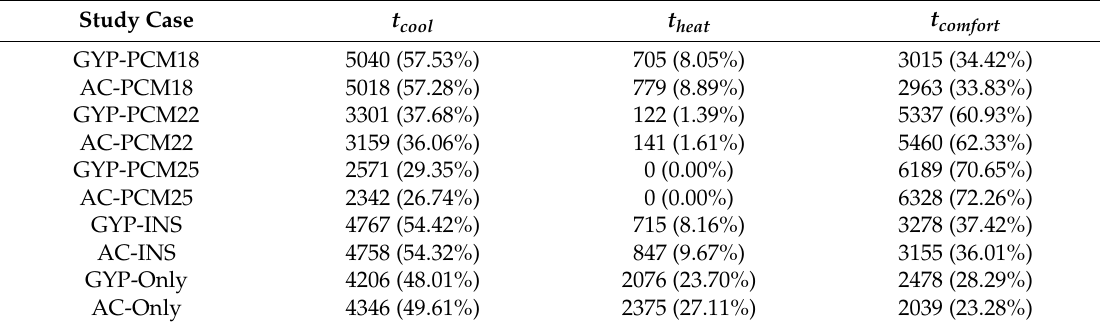
Table 7. The number of hours within a typical year when indoor temperatures corresponding to all case scenarios remained within the thermal comfort range ( t comfort ), below the thermal comfort range ( t cool ), and over the thermal comfort range ( t heat